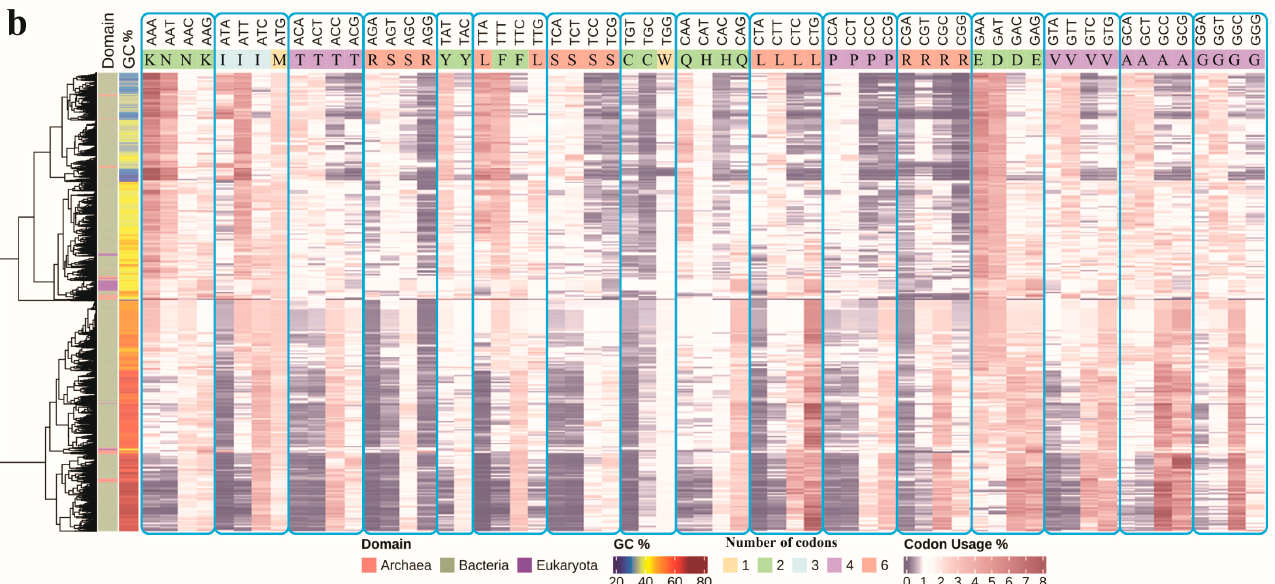
Figure 1. Amino acid and genetic codon usage landscapes in the three domains of life. ( a ) Results of the ranking of amino acids usage in species. The results are displayed from high to low, where different colours represent the different number of codons encoding amino acids. The columns headed Total, Bacteria, Archaea and Eukaryota indicate the order of amino acid usage by all species, all bacterial species, all archaeal species and all eukaryotes, respectively. The last column represents the theoretical ranking of amino acid usage. Other columns represent the amino acid usage ranking of species (see Table S5 for abbreviations). ( b ) Heatmap analysis of codon usage (excluding stop codons, ComplexHeatmap R package). Hierarchical clustering of the GC content and domain of life of each species ( n = 7270). The horizontal bars indicate the codon and amino